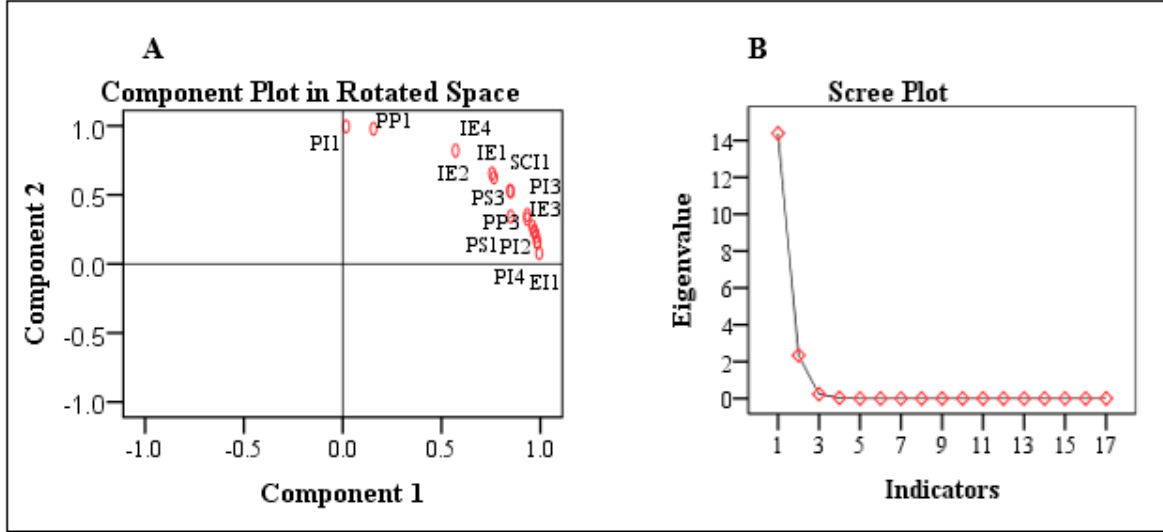
Figure 4. Indicator’s linkage in principal components in a two-dimensional specie ( A ) and scree plot; eigenvalues plotted in descending order ( B ).